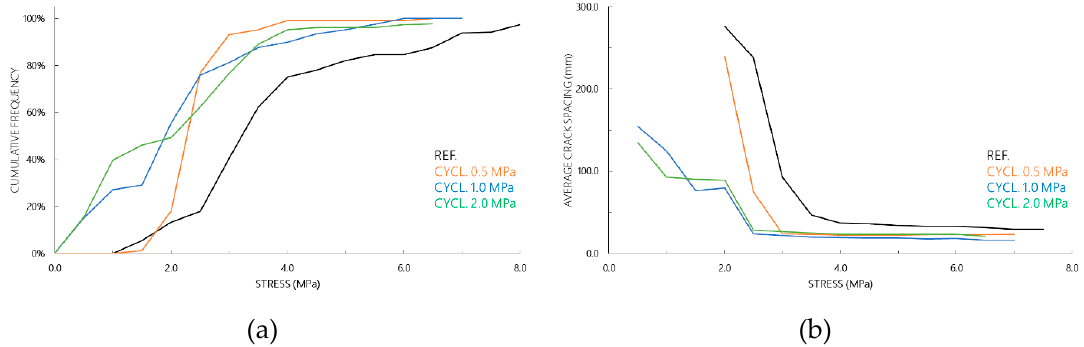
Figure 13. The number of cracks present in the different samples was used to compare: ( a ) the average cumulative frequency and ( b ) the average crack spacing.